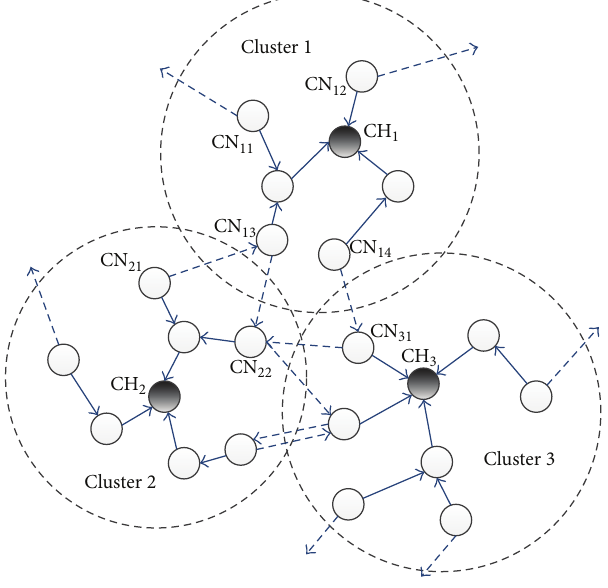
Figure 1: The slicing